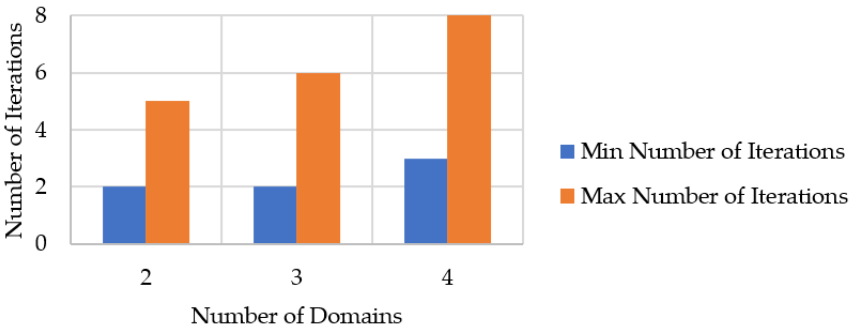
Figure 11. Dependence of the coordination procedure number of iterations on the network domains number.